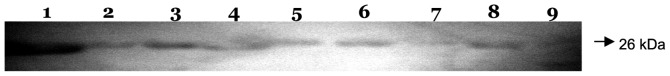
GSTP1 western blot from breast tissue biopsies. Lanes 1 and 2 show GSTP1 expression in control sample, lanes 3–9 show varying levels of GSTP1 expression in different breast carcinoma individuals.